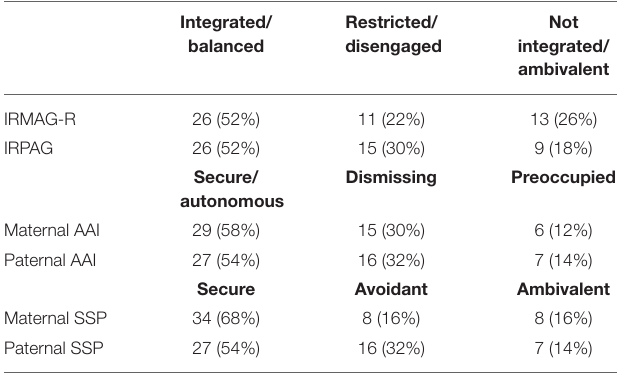
TABLE 2 | Descriptive statistics of quantitative scales. TABLE 1 | Frequency and percentages of IRMAG-R and IRPAG, maternal and paternal AAI, and maternal and paternal SSP categories. Maternal Integrated/ Restricted/ Not balanced disengaged integrated/ ambivalent